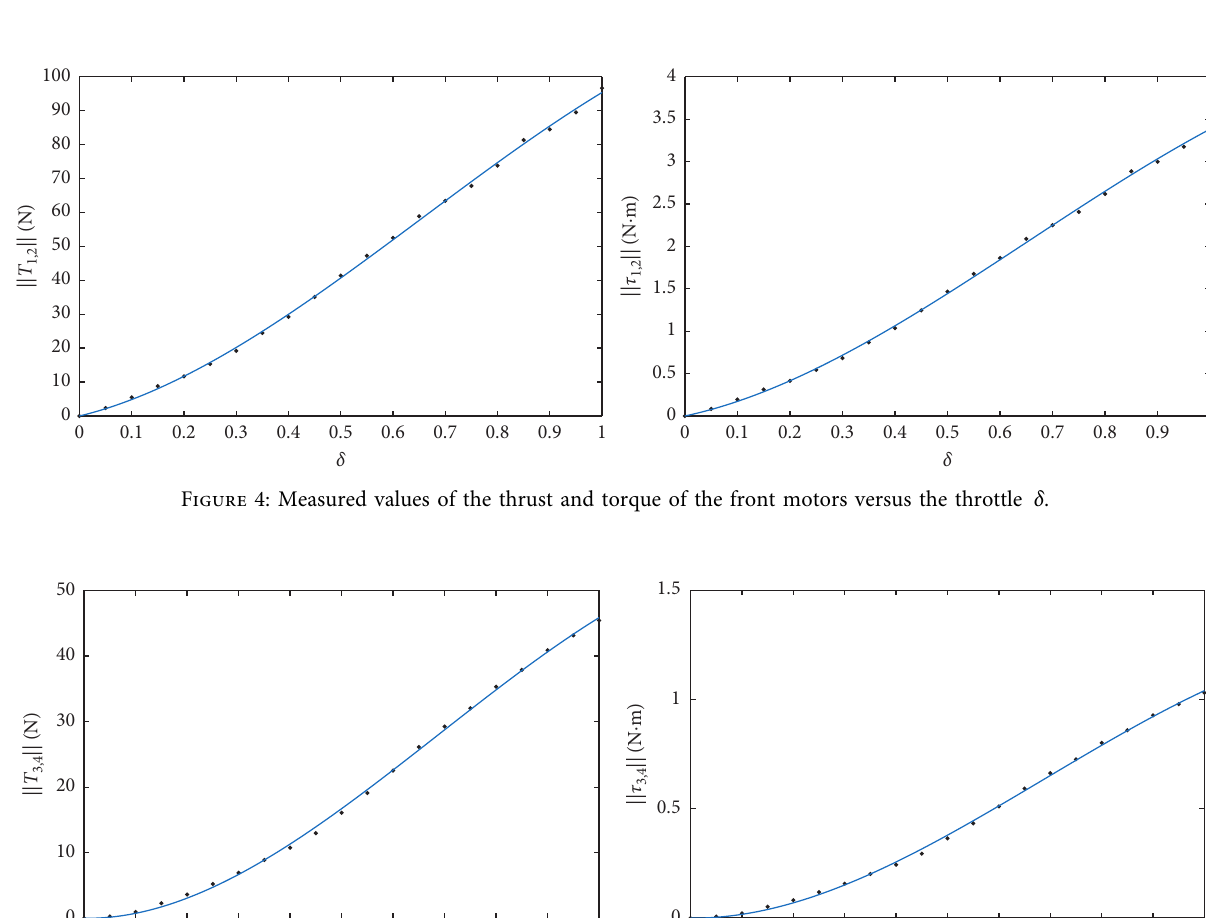
Figure 3: Left: scheme of the measurement chain. Right: schematic diagram of the testbed installation. DAQ: data acquisition.